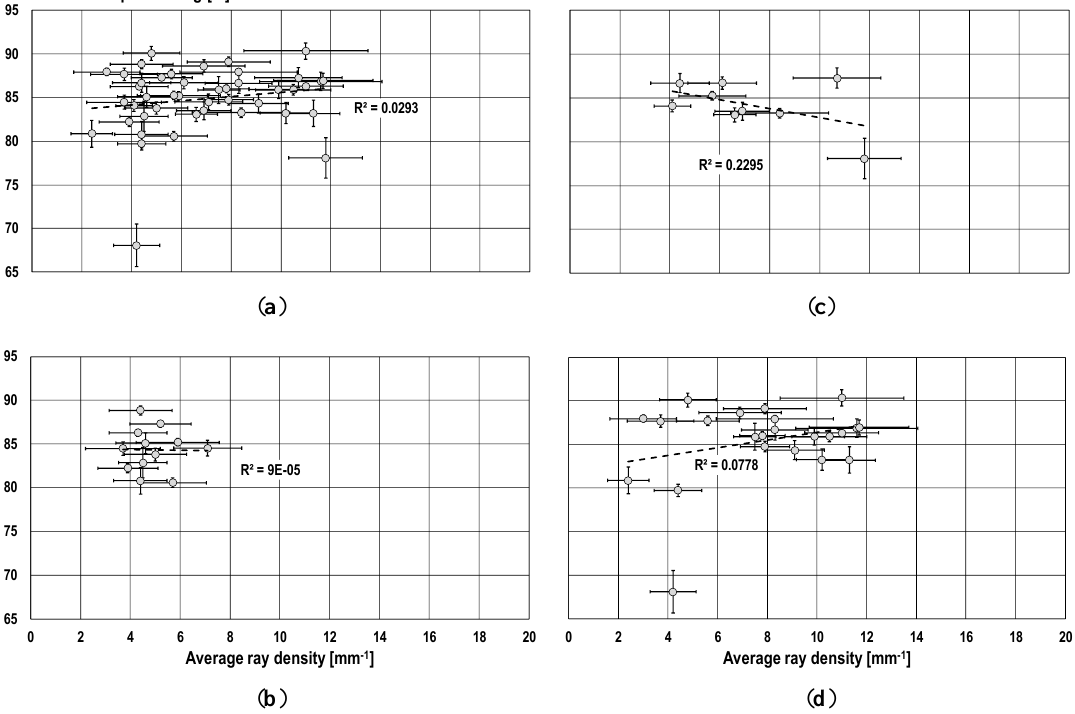
Figure 4. The relationship between the average ray density and the Resistance to Impact Milling (RIM): ( a ) all wood species (y = 0.2354x + 83.247); ( b ) softwoods (y = −0.0252x + 84.454); ( c ) ring- and semi-ring-porous hardwoods (y = −0.5083x + 87.875); ( d ) and diffuse-porous hardwoods (y = 0.4365x + 81.997).